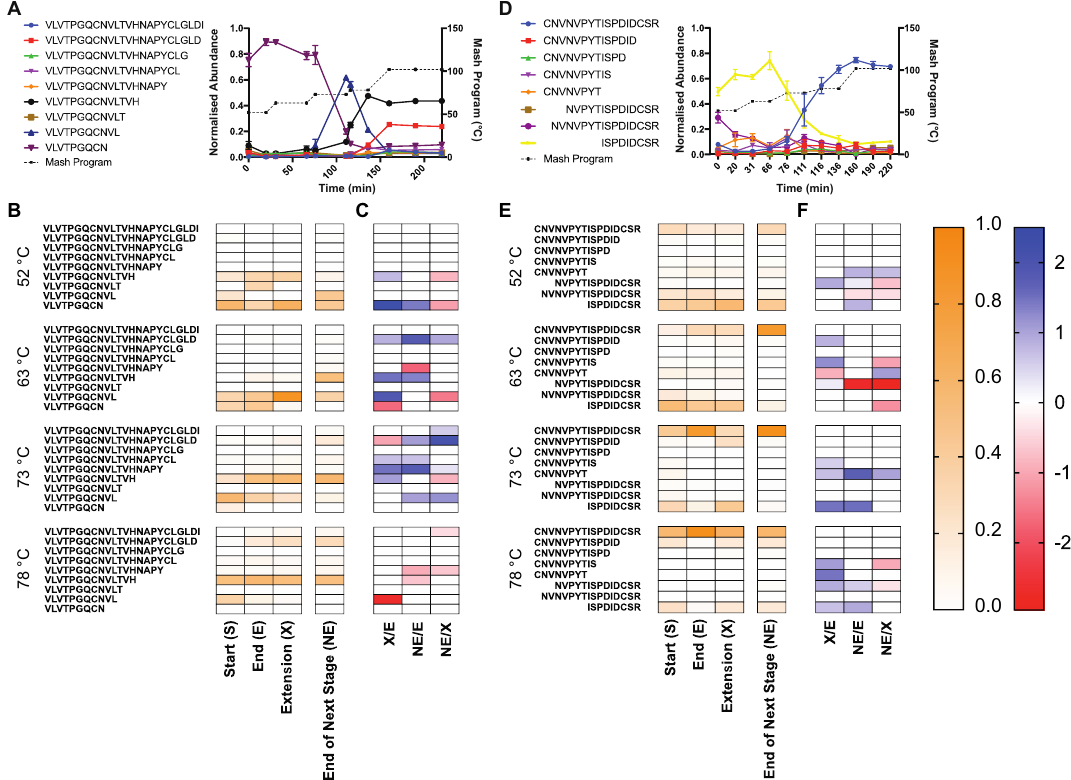
Figure 6. Time- and temperature-dependent abundance of full- and semi-tryptic peptides during the mash and boil. ( A ) Normalised abundance (a.u; arbitrary units) in a 23 L mash of full- and semi- tryptic peptides corresponding to V 122 LVTPGQCNVLTVHNAPYCLGLDI 145 from IAAA. ( B ) Heatmap of normalised abundance in a 1 mL mash of IAAA full- and semi- tryptic peptides corresponding to V 122 LVTPGQCNVLTVHNAPYCLGLDI 145 at the start, end, extension, and end of the next step across the mash. ( C ) Log 2 (fold change) of peptides that were significantly differentially abundant ( p < 10 −5 ) between the designated stages of the 1 mL mash: end of stage (E), extension of stage (X), end of the next stage (NE). ( D ) Normalised abundance (a.u; arbitrary units) in a 23 L mash of full- and semi-tryptic peptides corresponding to C 99 NVNVPYTISPDIDCSR 115 -I from NTLP1. ( E ) Heatmap of normalised abundance in a 1 mL Mash of NLTP1 full- and semi- tryptic peptides corresponding to K-C 99 NVNVPYTISPDIDCSR 115 -I at the start, end, extension, and end of the next step across the mash. ( F ) Log 2 (fold change) of peptides that were significantly differentially abundant ( p < 10 −5 ) between the designated stages of the 1 mL mash: end of stage ( E ), extension of stage (X), end of the next stage (NE). ( A and D ) Values show mean, n = 3. Error bars show SEM. Mash temperature profile is shown on the right Y-axis. Mash program is shown in black dotted lines; points indicate when samples were taken. ( B and E ) Values show mean, n =